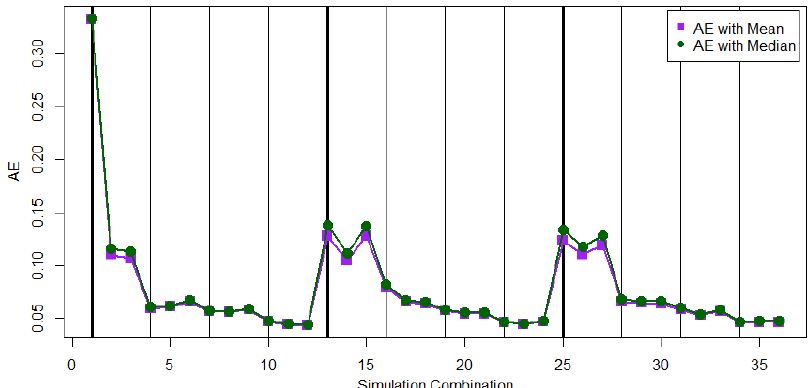
Figure 5. The EAEs of ˆ δ SE and ˆ δ AE for the case of β 1 (cid:54) = β 2